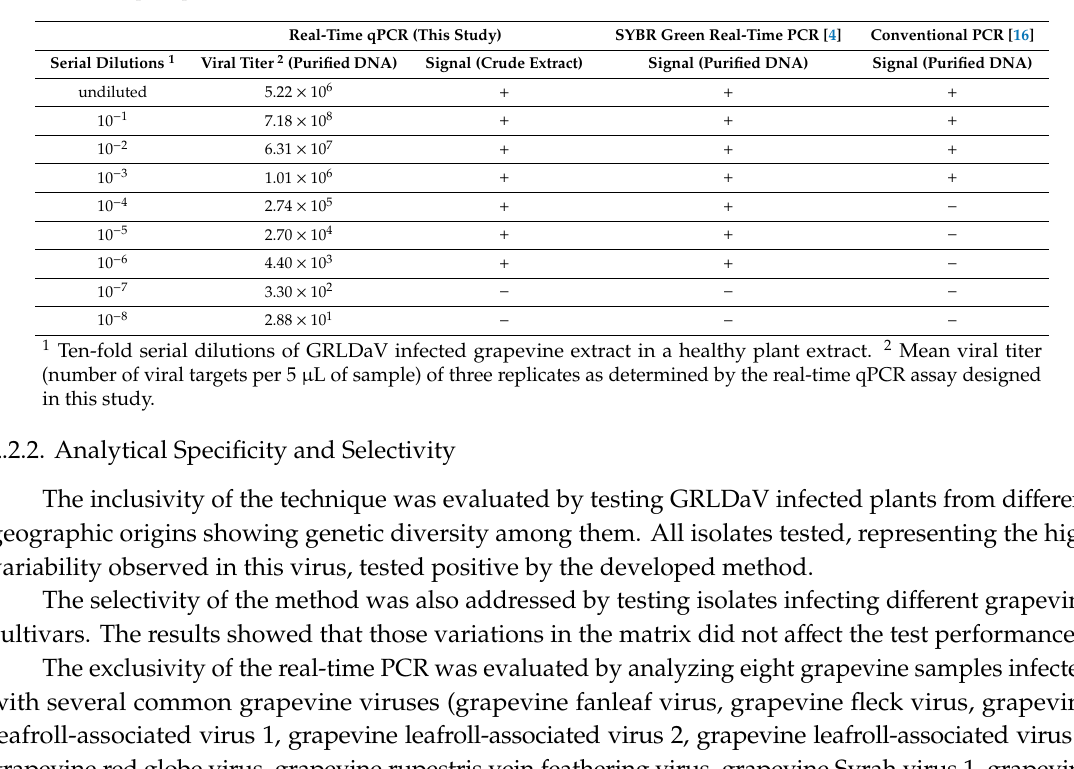
Table 1. Analytical sensitivity of the real-time qPCR developed compared to the sensitivity of two previously reported Grapevine Roditis leaf discoloration-associated virus (GRLDaV) detection methods [4,16].